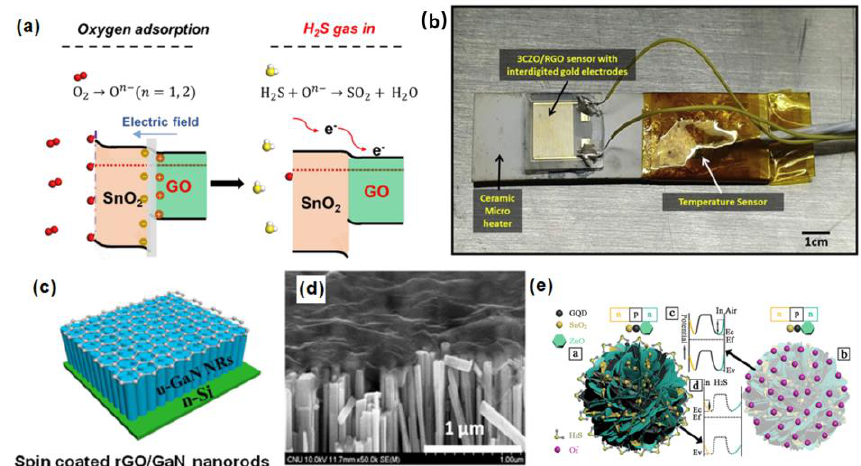
Figure 8. ( a ) Schematic diagram of H 2 S adsorption mechanism based on SnO 2 @GO gas sensor [75]. Copyright (2020), used with permission from Elsevier. ( b ) CZO/rGO sensor structure [76]. Copyright (2020), used with permission from Elsevier. ( c ) Schematic diagram of rGO)/GaN nanorods (NRS); ( d ) scanning electron microscope (SEM) image of rGO/GaN nanorod (NRS) composite material [77]. Copyright (2020), used with permission from Wiley. ( e ) Schematic diagram of band configuration at the interface of the GQD–SnO 2 /ZnO [81]. Copyright (2021), used with permission from the American Chemical